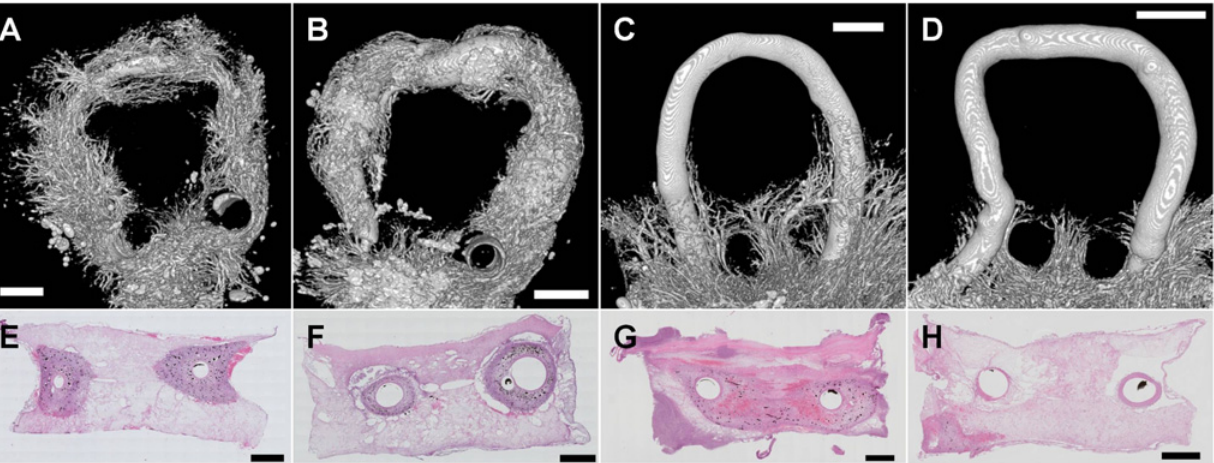
Fig 6. Vessel formation in arterioarterial (AA) and arteriovenous (AV) loops at day 15. Micro-CT images were acquired after injection of appropriate dye shortly after sacrifizing the animal and explantation of the loops. Representative examples of reconstructed images of AV loops (A,B) show extensive formation of new vessels arising along the overall length of the grafted vein. In marked contrast, newly formed vessels in AA loops (C,D) were only present at the entrance and exit of the loop in and out of the chamber (bottom), but not arising from the grafted vein within the loop (top and middle). Histological slices of AV loops (E,F) reveal new vessels in close proximity to the grafted vein which are stained with black ink that was injected into the aorta before explantation verifying perfusion. The lack of angiogenesis from the graft in AA loops was observed also in histological preparations (G,H). Newly formed vessels were absent (H) or in a greater distance from the graft (G). Scale bars: 1000 μ m.